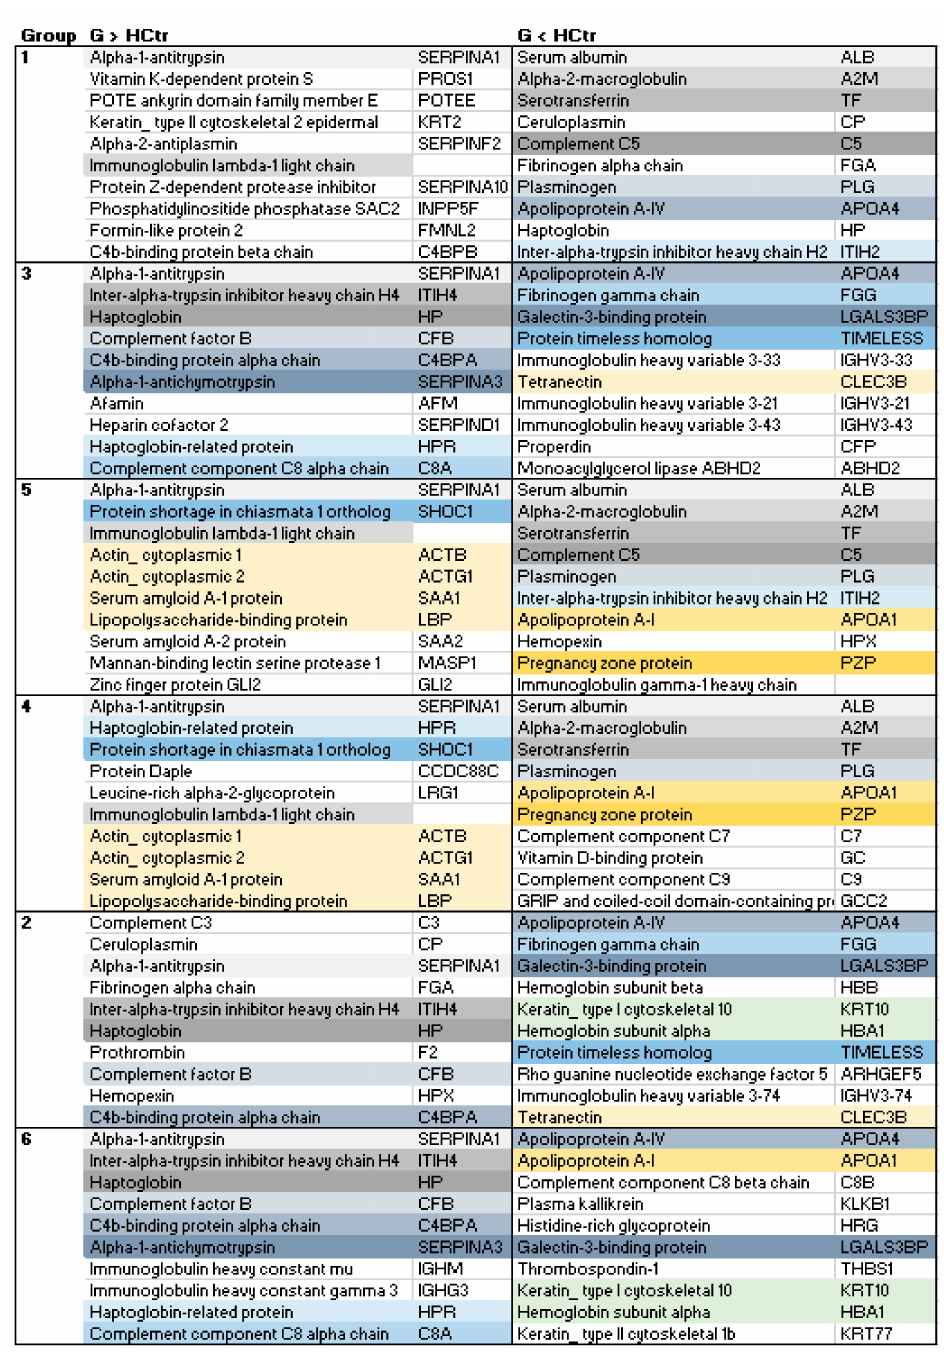
Figure 10. Top 10 most regulated proteins (based on highest confidence) for groups G1 to G6 in comparison to HCtr. Upregulated: G > HCtr, downregulated: G < HCtr. Color-coding highlights the same proteins in different